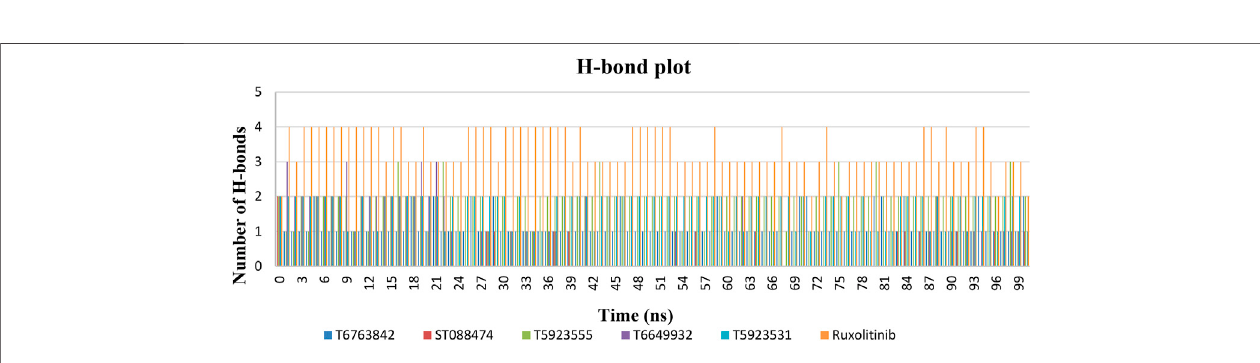
FIGURE 9 | The number of hydrogen bonds formed by lead compounds and drug over the simulation time.